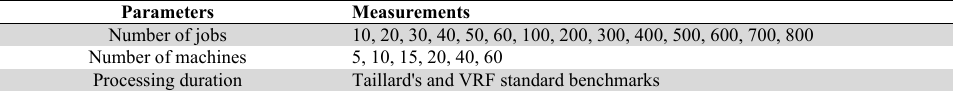
Parameters and Measurements Parameters